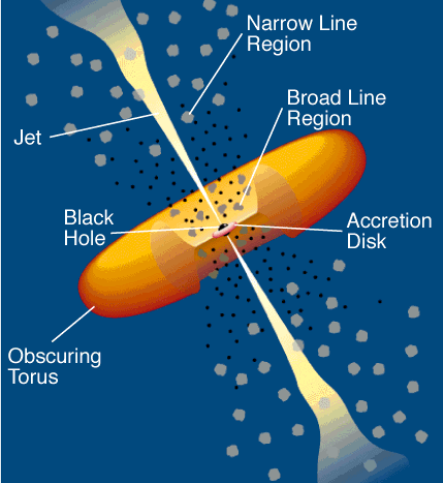
Figure 5. A schematic picture of blazars. (Credit